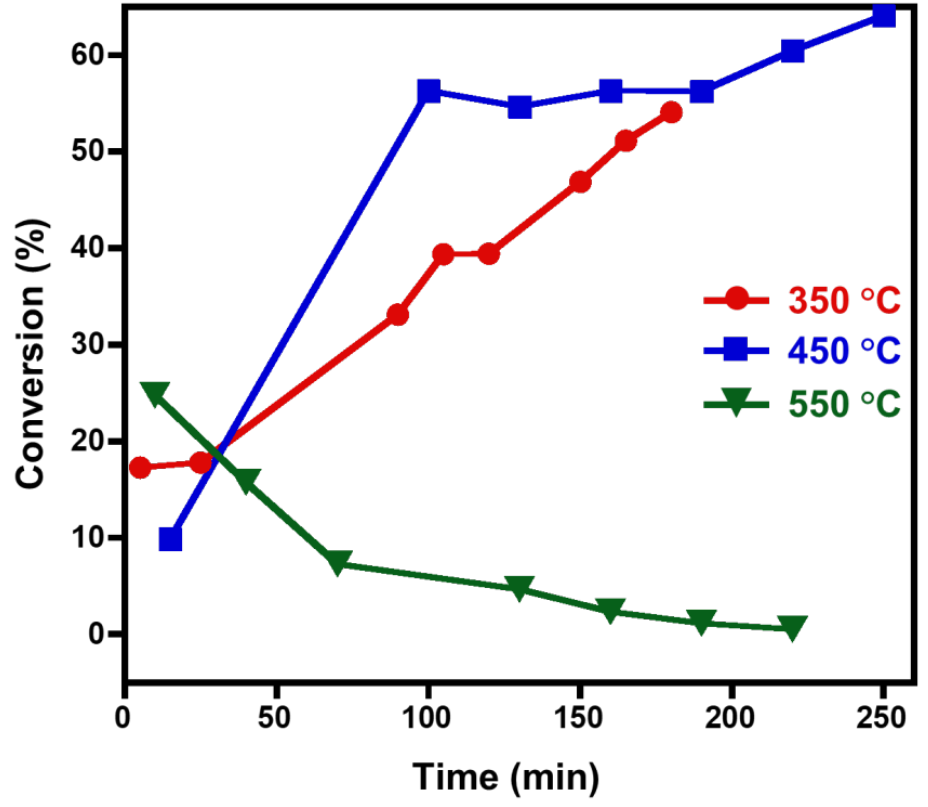
Figure 8. Effect of calcination temperature on the conversion of toluene to benzaldehyde (conditions: catalyst amount: 0.3 g; toluene flow: 0.01 mL/min; reaction temperature: 250 °C).